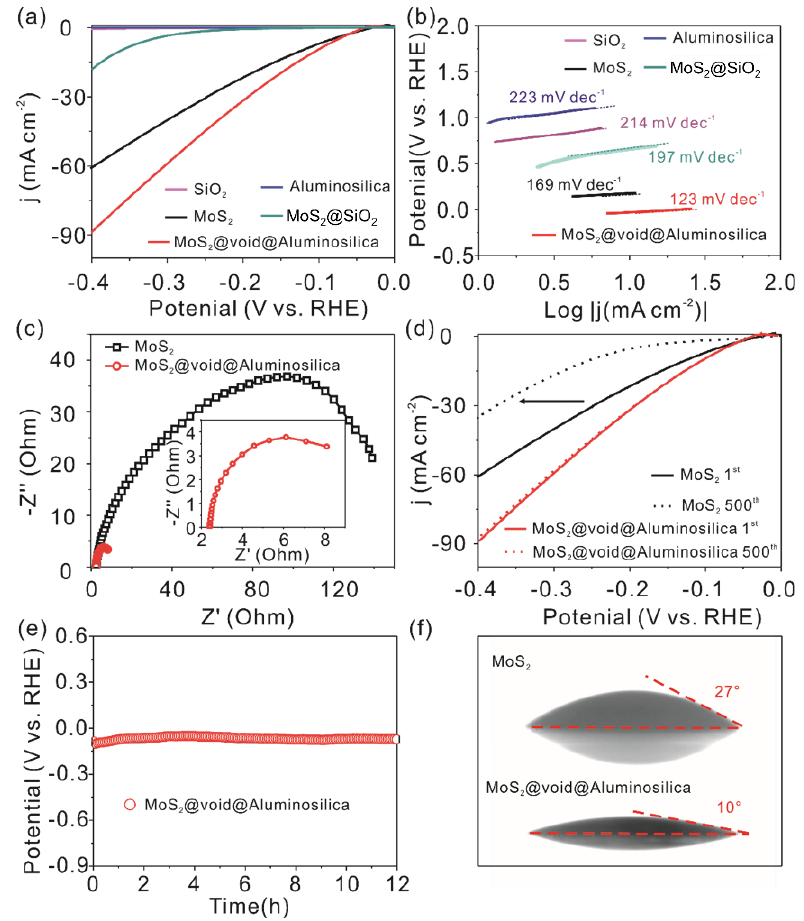
Figure 6. ( a ) HER polarization curves without iR-compensation; ( b ) Tafel slopes; ( c ) EIS; ( d ) LSV Figure curves for before and after 500 CV cycles; ( e ) chronopotentiometry curve of the MoS 2 @void@Alumi- nosilica microspheres at the constant current density of − 10 mA cm −2 ; ( f ) contact angle measure- ments of the MoS 2 microspheres and the MoS 2 @void@Aluminosilica microspheres.